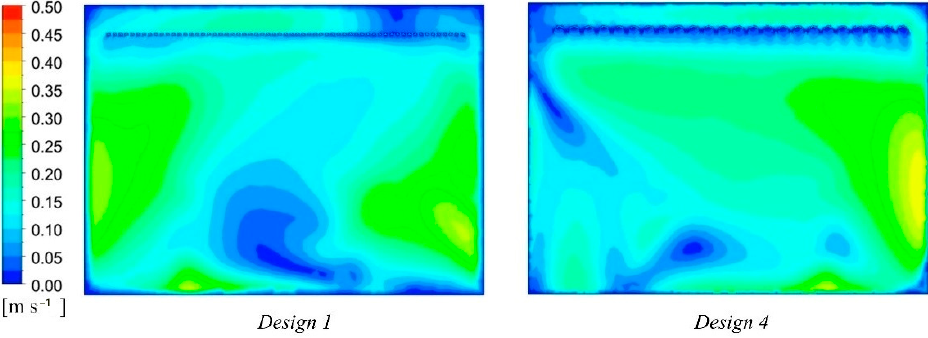
Figure 7. Velocity contours in Design 1 and Design 4 under a cooling load of 1405.02 W.